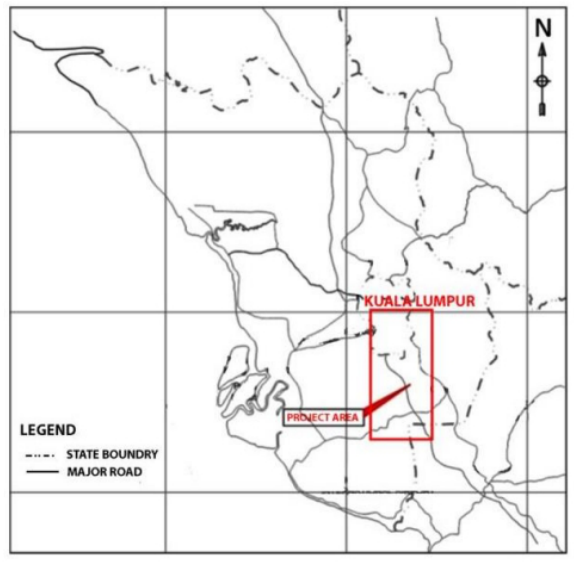
Fig. 1. Location of the KVMRT project